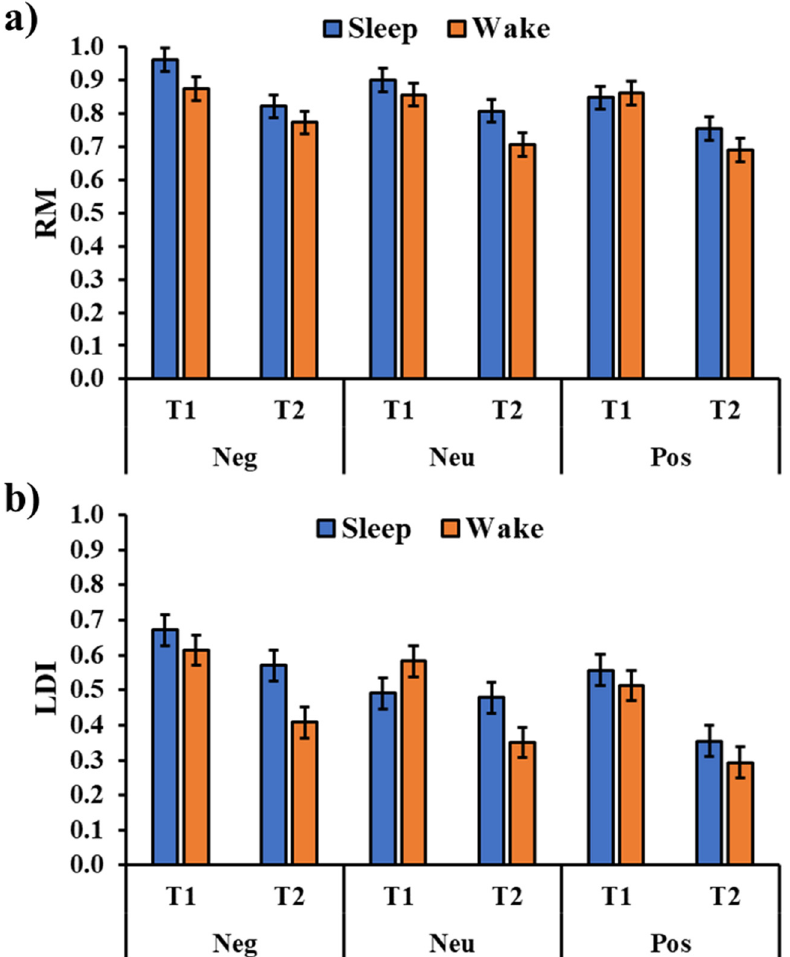
Figure 3. Recognition memory (RM, ( a )) and Lure Discrimination Index (LDI, ( b )) for the three types of images (Neg: Negative, Neu: Neutral, Pos: Positive) in the two groups and the two sessions (T1, T2). The error bars represent the standard error of the means.